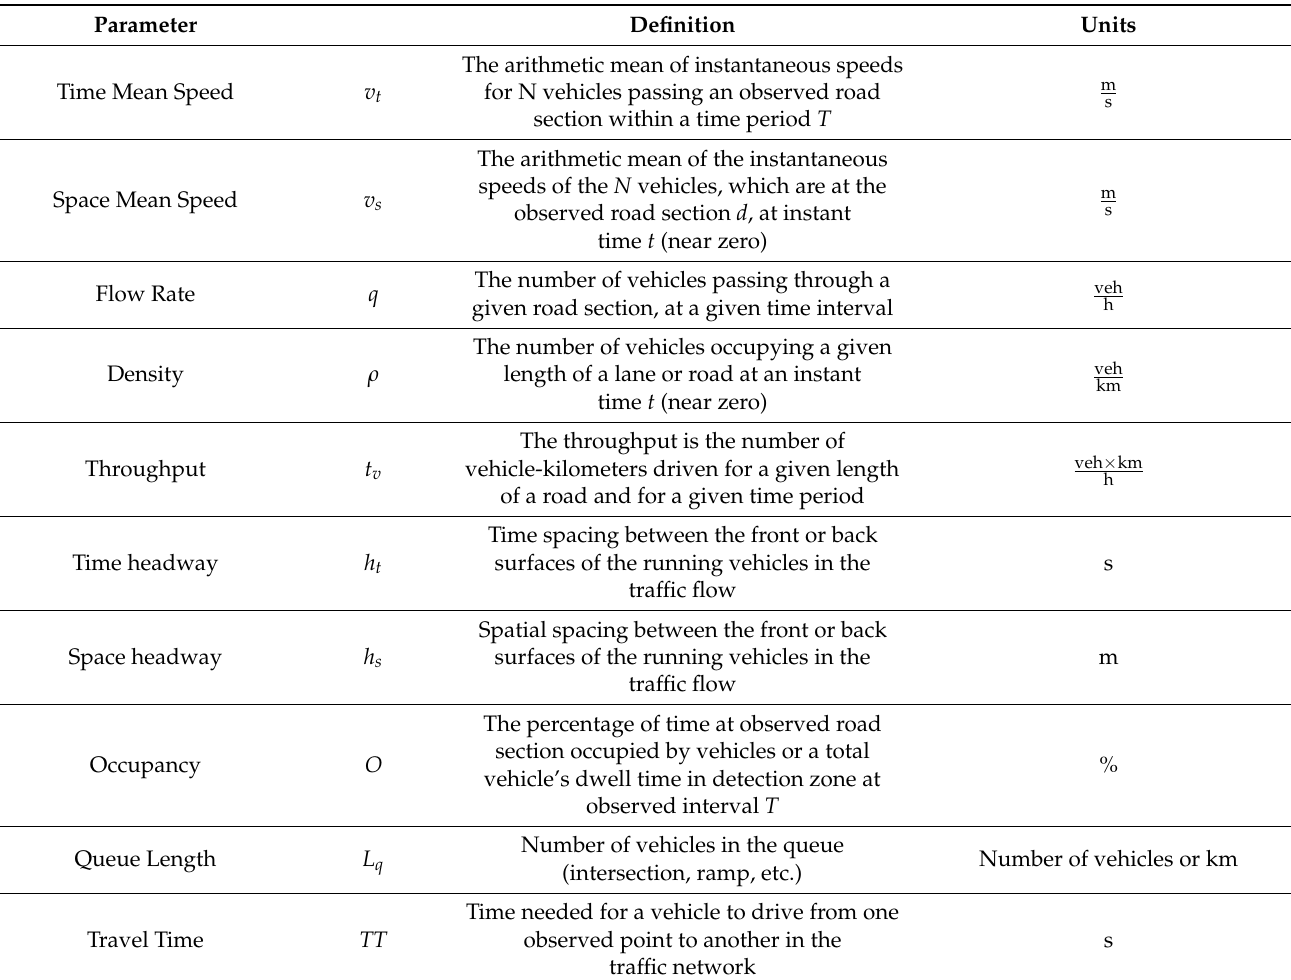
Table 1. Traffic Flow Parameters Used as Congestion